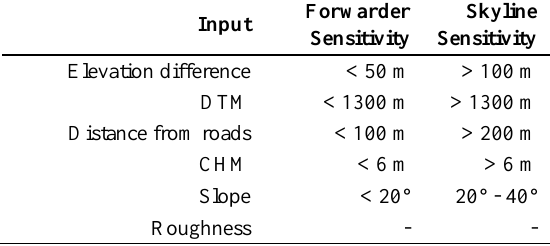
Table 4. Class sensitivity for the input layers using